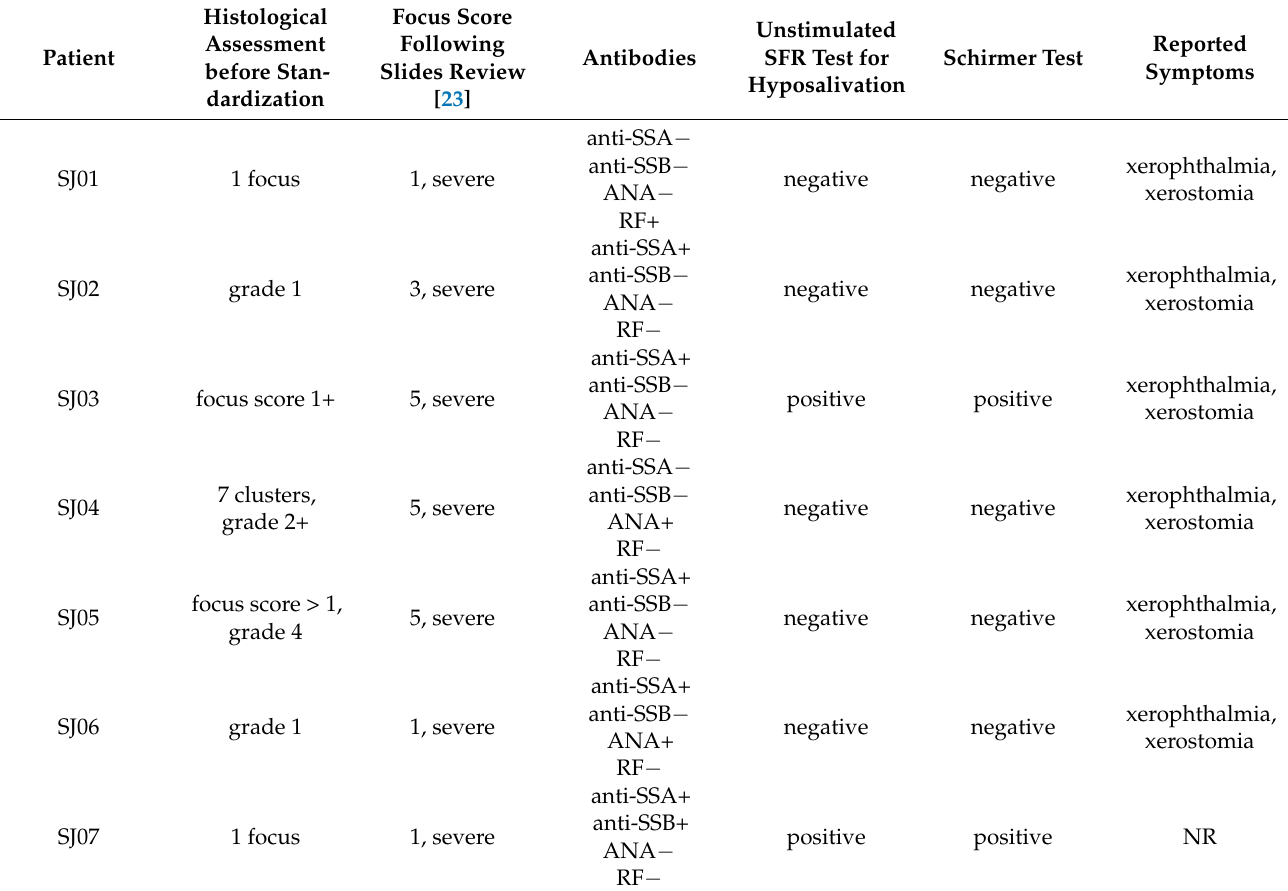
Table 1. Histological, serological, and clinical characterization of enrolled